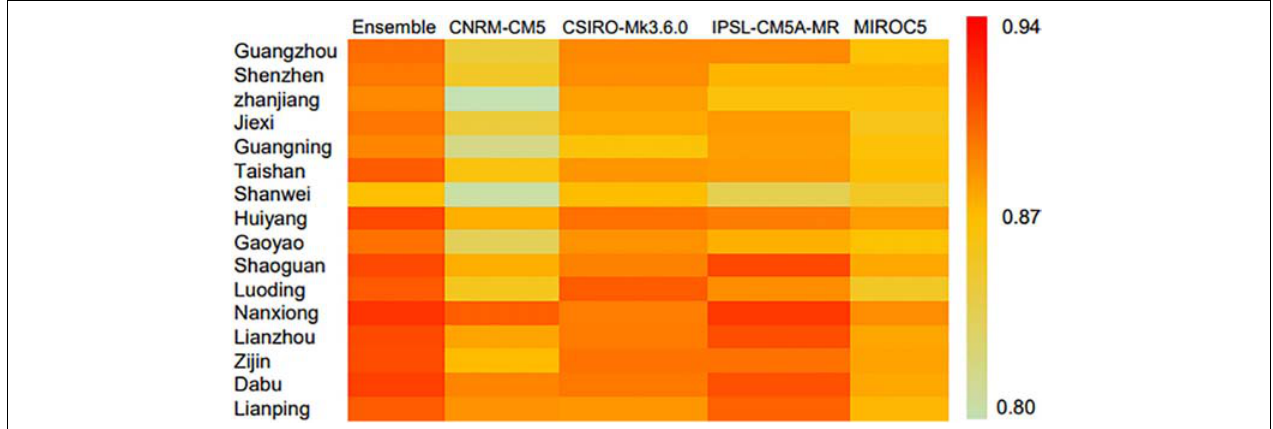
FIGURE 4 | Comparisons of the monthly average between observed Tmax and downscaled outputs from CNRM-CM5, CSIRO-Mk3.6.0, IPSL-CM5A-MR, MIROC5, and their ensemble, 1991–2005 [color bars represent the coefficient of determination ( R 2 ) value between observed Tmax and downscaled